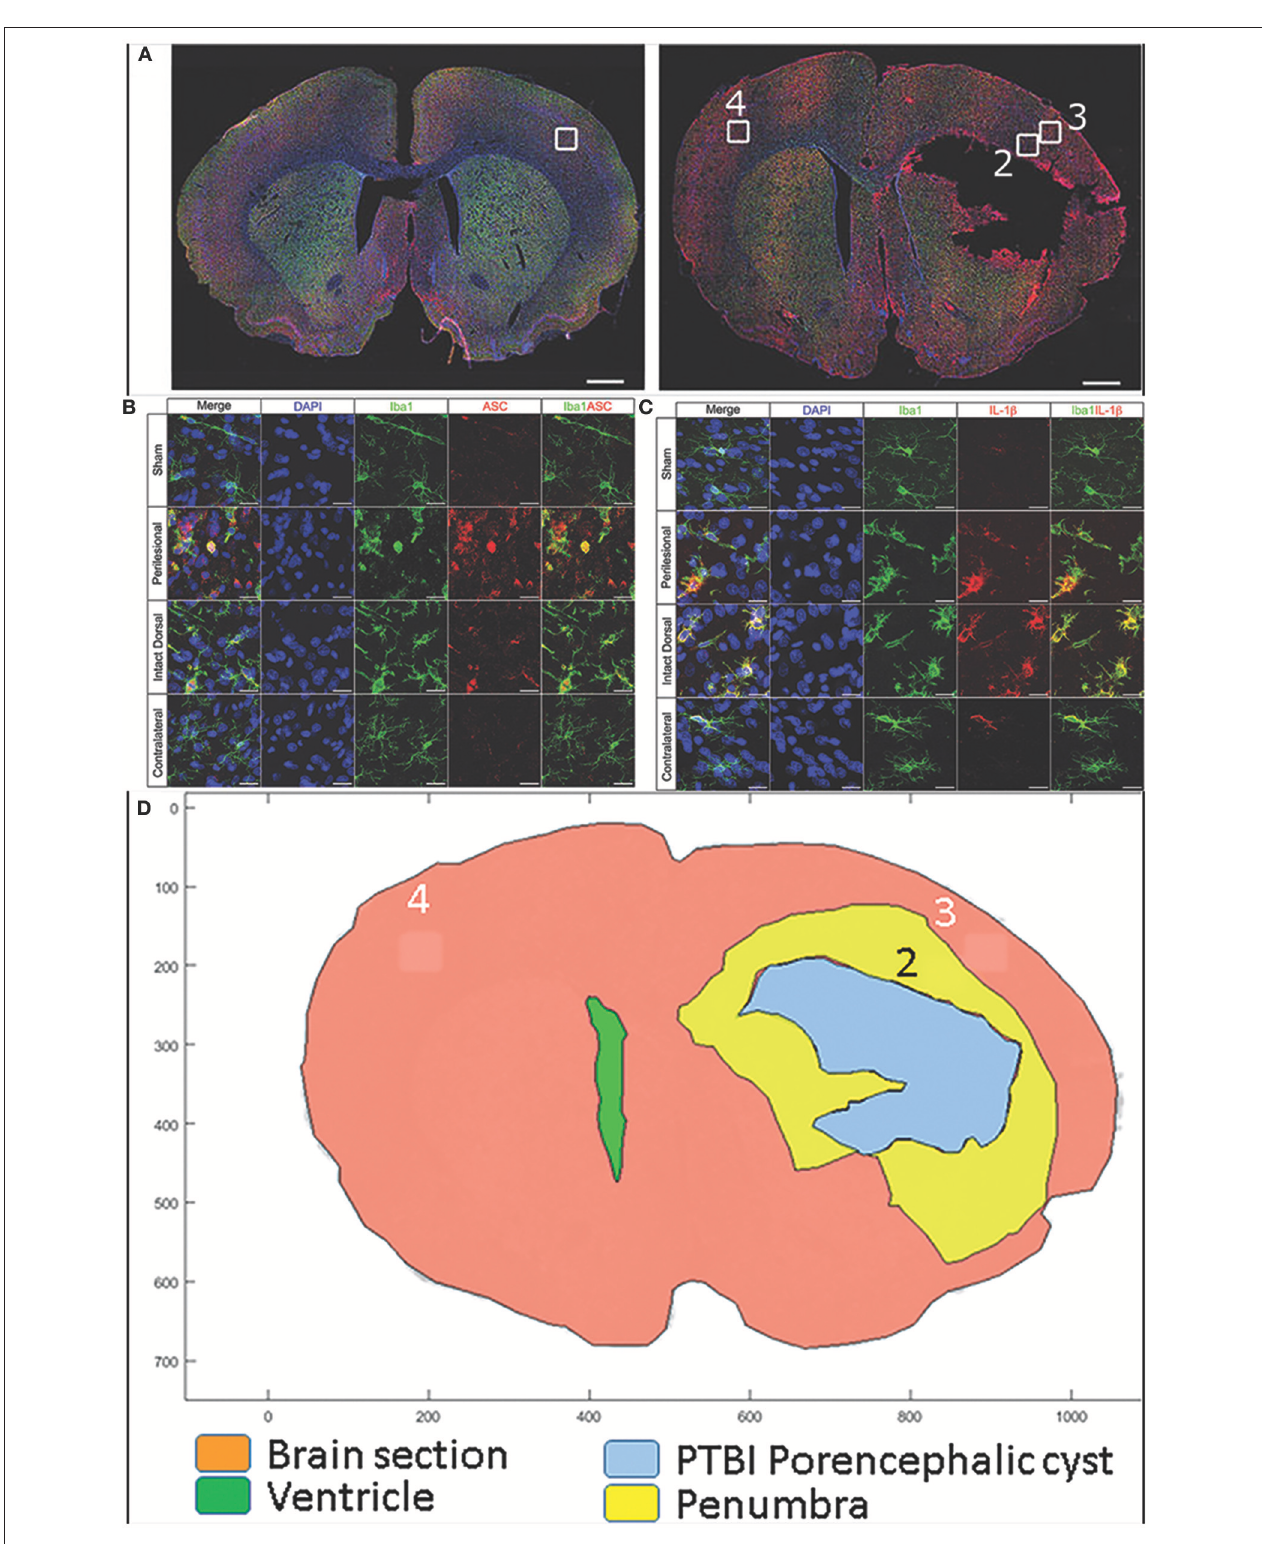
FIGURE 2 | Confocal images of free-floating rat brain sections stained with 2-(4-amidnophenyl)-1H-indole-6-carboxmidine (DAPI; blue), ionized calcium-binding adapter molecule 1 (Iba-1; green), and apoptosis speck-like protein containing caspase-activation and recruitment domain (ASC) or interleukin (IL)-1b (red). Top panels (A) show whole–brain sections from a representative sham (left) and 10% penetrating ballistic-like brain injury (PBBI) animal 48h after injury (right). Sections show